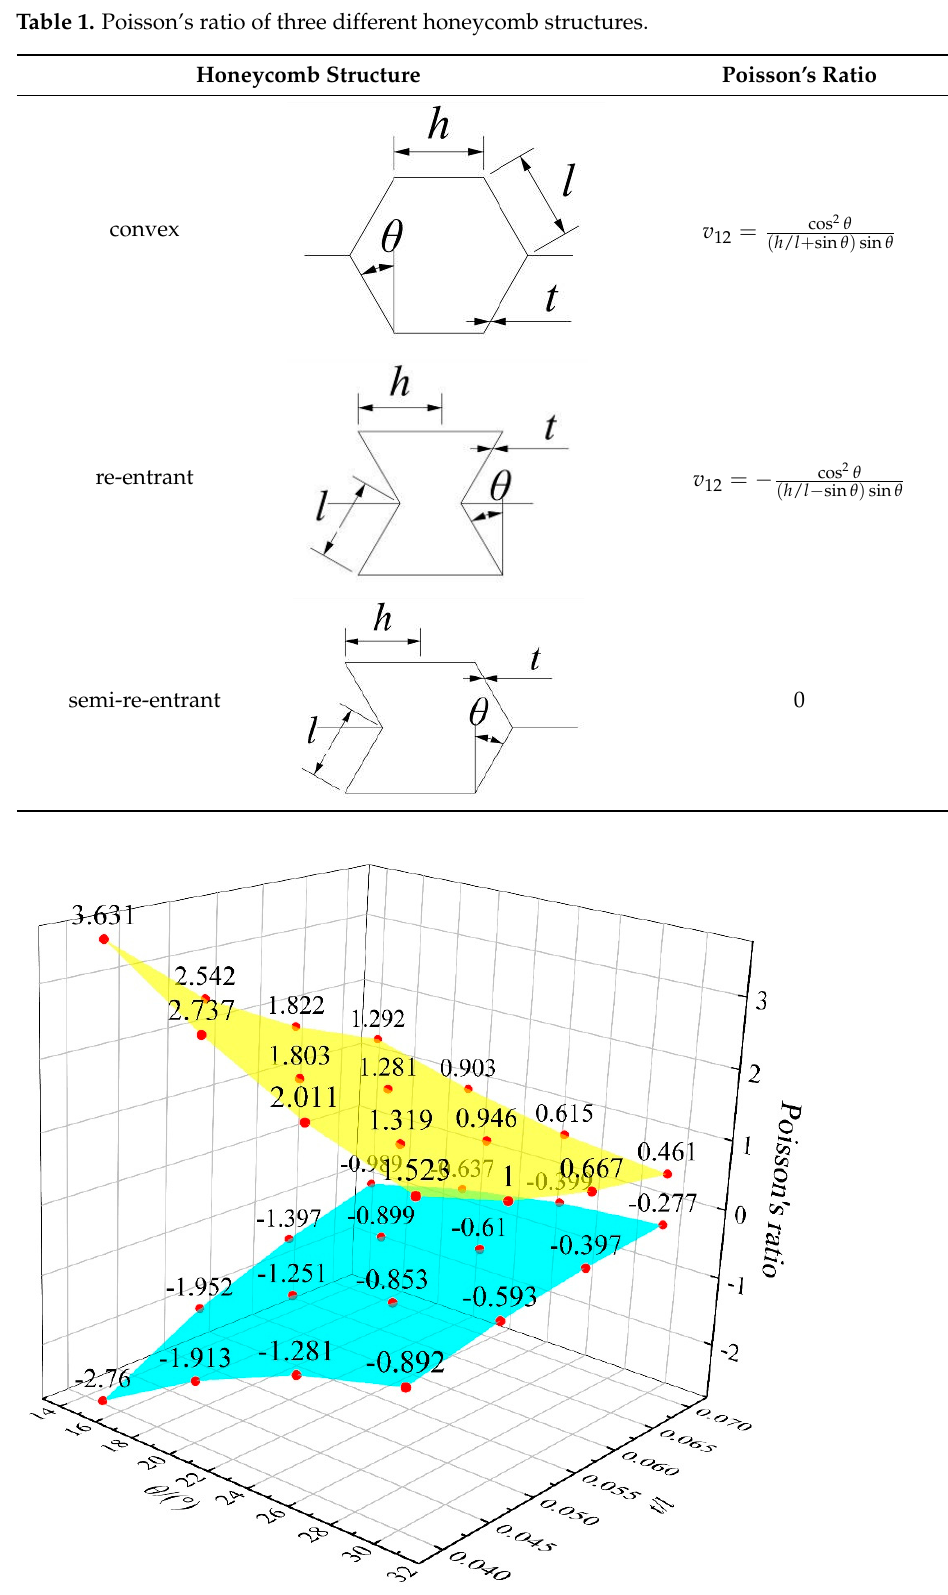
Figure 1. The Poisson’s ratio of the honeycomb structure with different geometries.